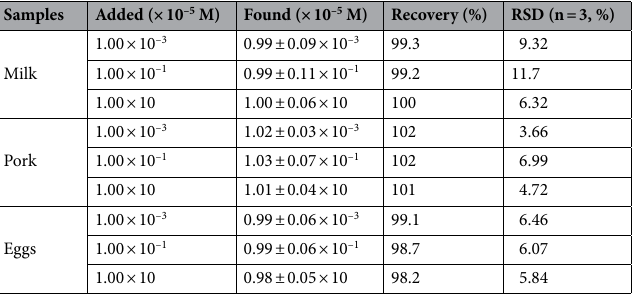
Table 1. Results of ROX detection in milk, pork, and eggs real samples by developed MIP/perovskites.